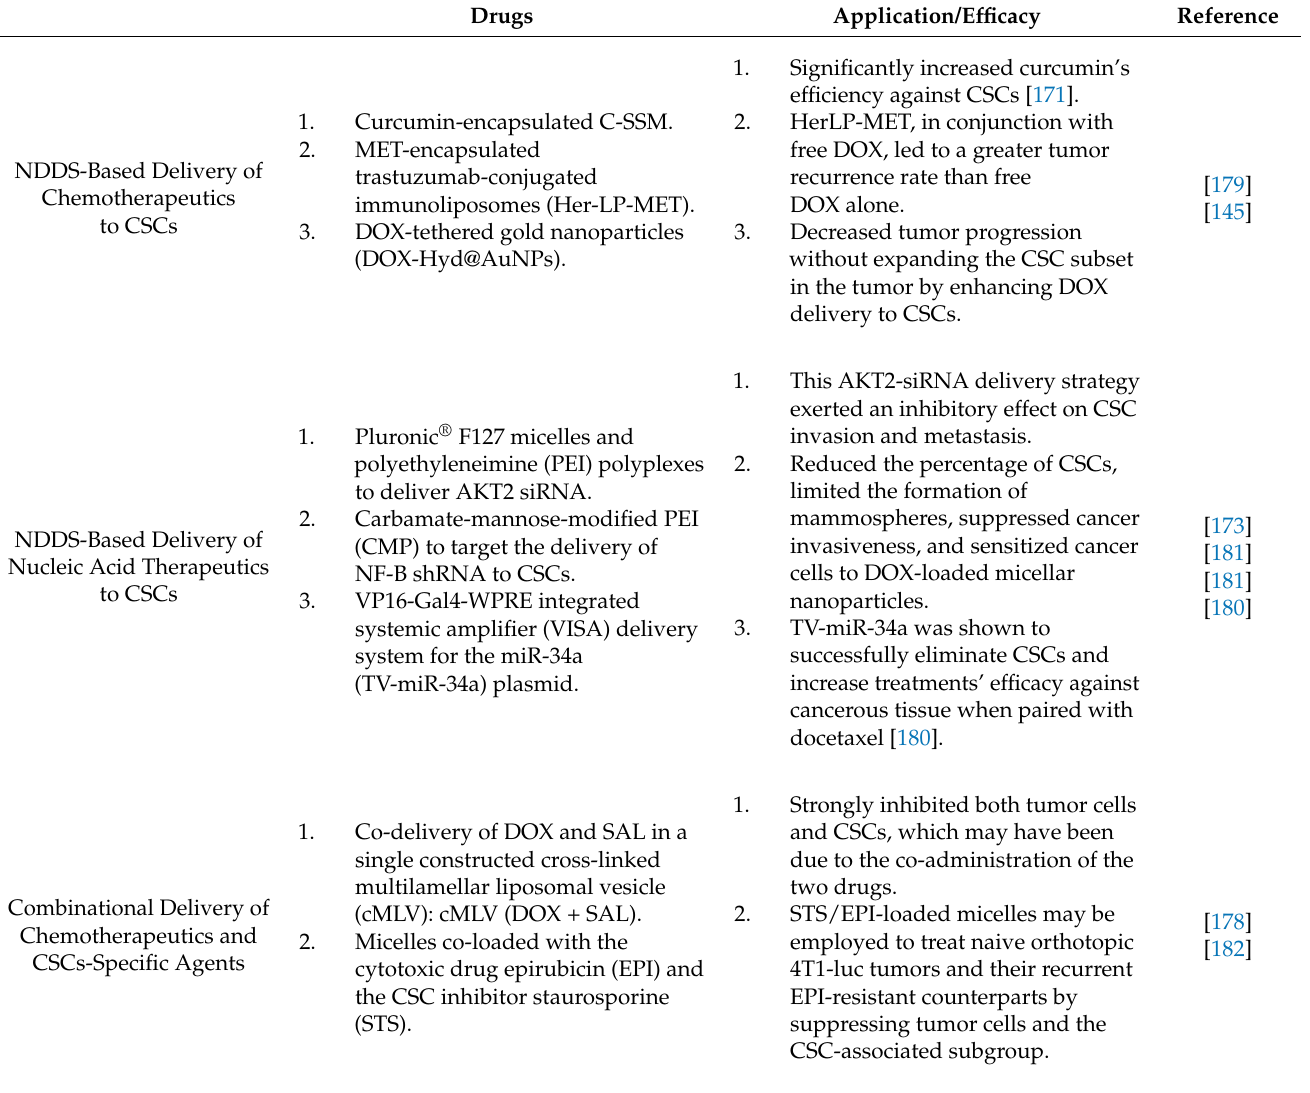
Table 2. Recent potential nanoparticle-based drug-delivery systems (NDDSs) for targeting CSCs.